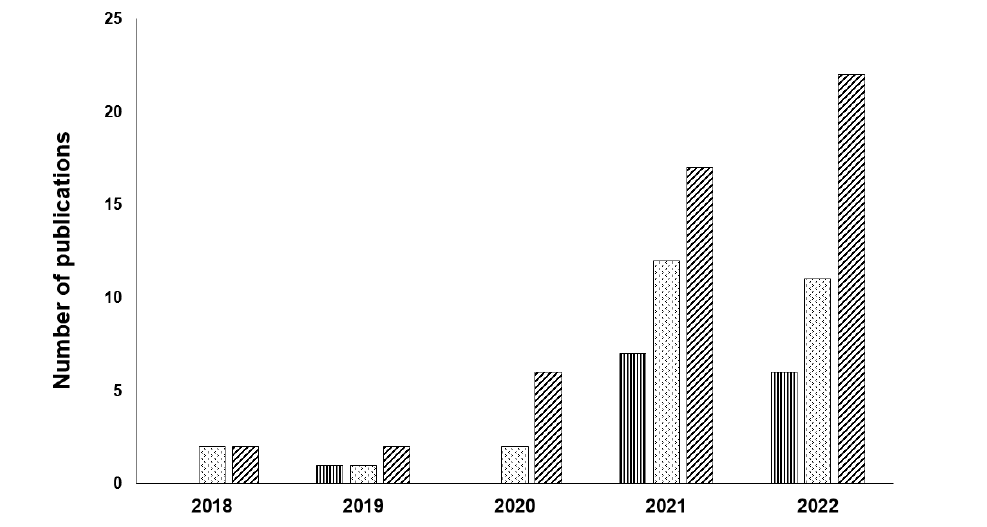
Figure 1. Publication trends in the application of 3D printing using food waste. Source: On- line Scopus database (www.scopus.com) using the keywords (“Food processing waste” AND “3D printing”; “Waste valorization” AND “3D printing”; “Food waste” AND “3D printing” (accessed on 22 December 2022).